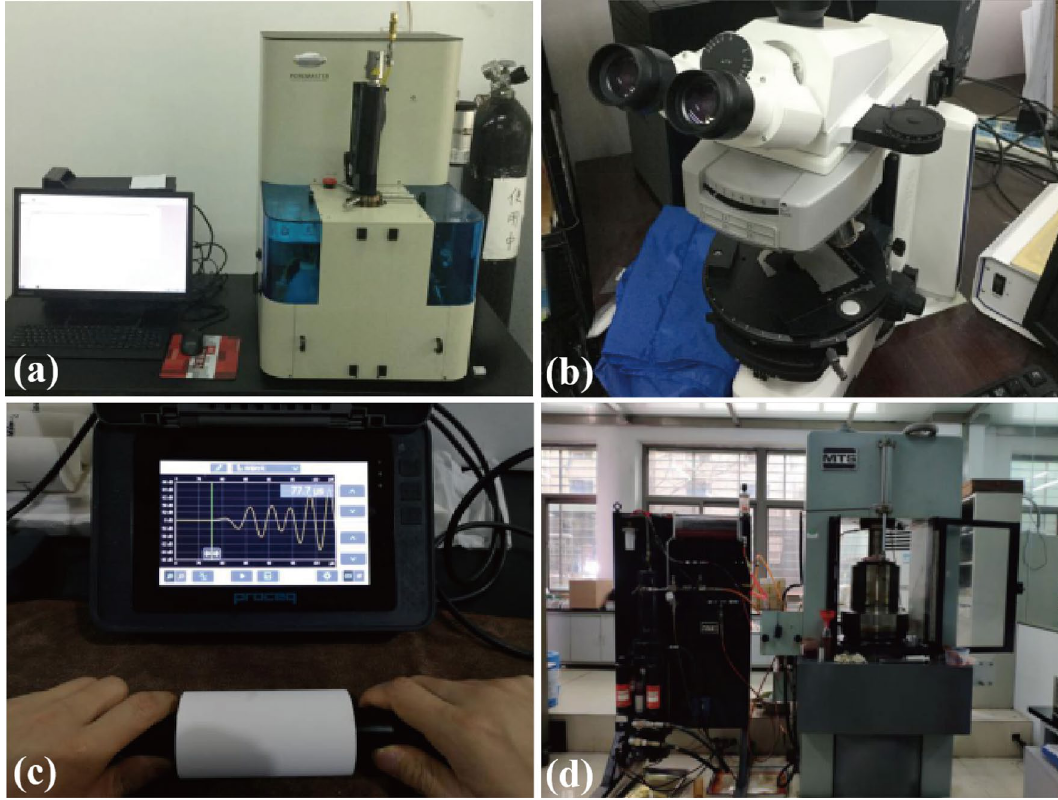
Figure 10. Testing equipment used in the study: ( a ) automatic mercury porosimeter (PoreMaster 60, Quantachrome Corporation, USA), ( b ) polarizing microscope (Axio Scope A1, Carl Zeiss Corporation, Germany), ( c ) ultrasonic pulse velocity testing equipment (Pundit PL-200, Proceq Group, Switzerland), and ( d ) MTS-815.03 rock testing system (MTS Systems Corporation,